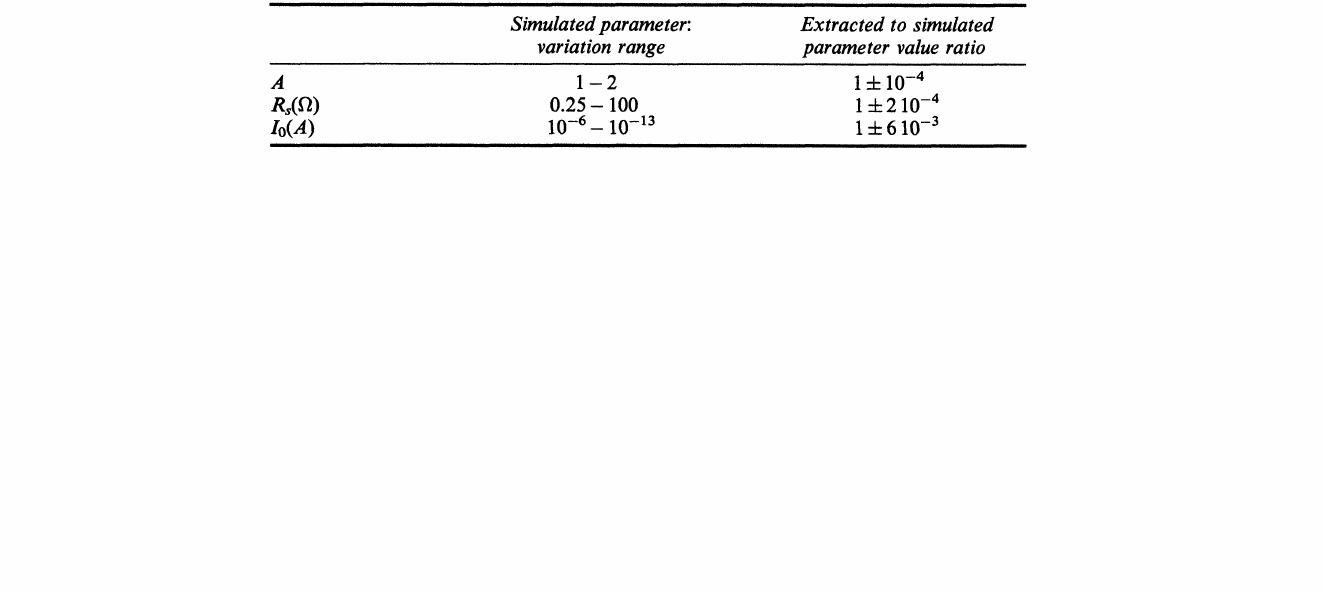
TABLE I Ratios of the extracted to simulated parameter values for simulated char- acteristics. In each case, only one parameter is varied in a specific variation range, the other are fixed with values A 1.5, R, Simulated parameter: Extracted to simulated variation